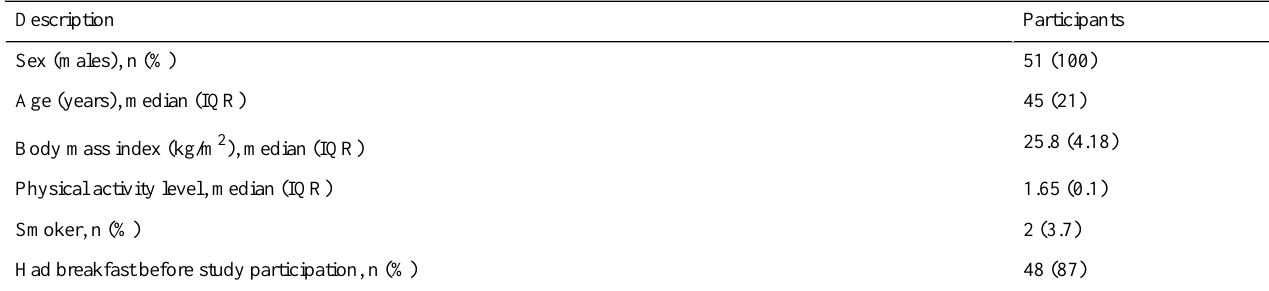
Table 1. Descriptive statistics of the study participants